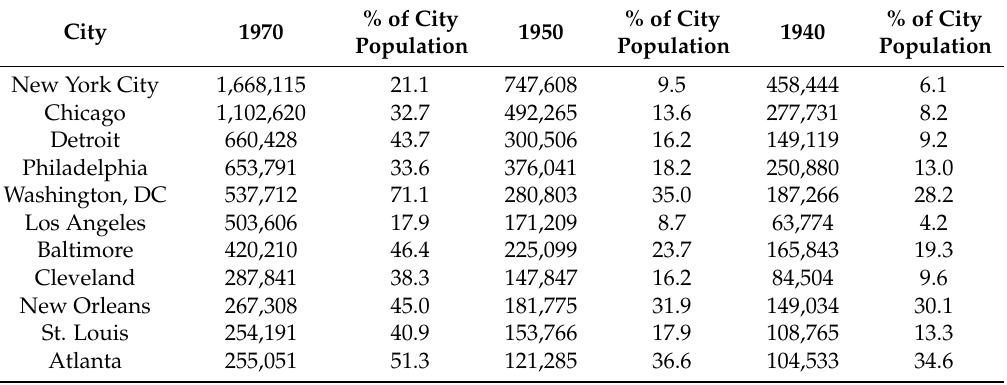
Table 1. Cities with the Largest Black Populations in the United States,